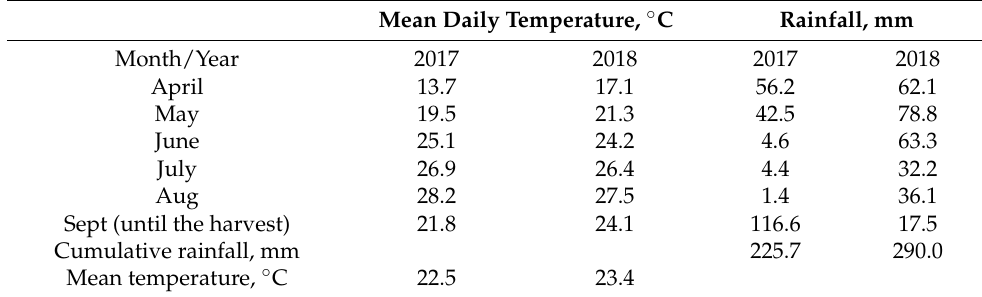
Table 1. Weather conditions in Kaštel Štafili´c during vegetation periods in 2017 and